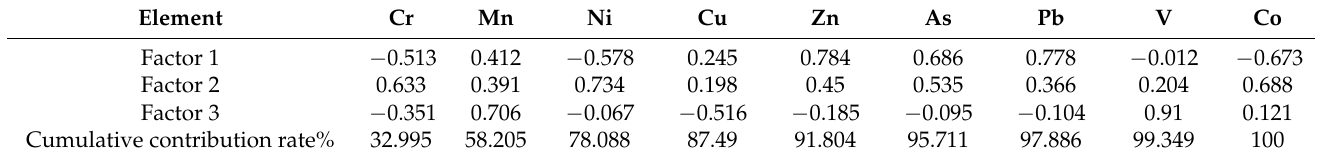
Table 7. Principal component analysis of heavy metal contents in